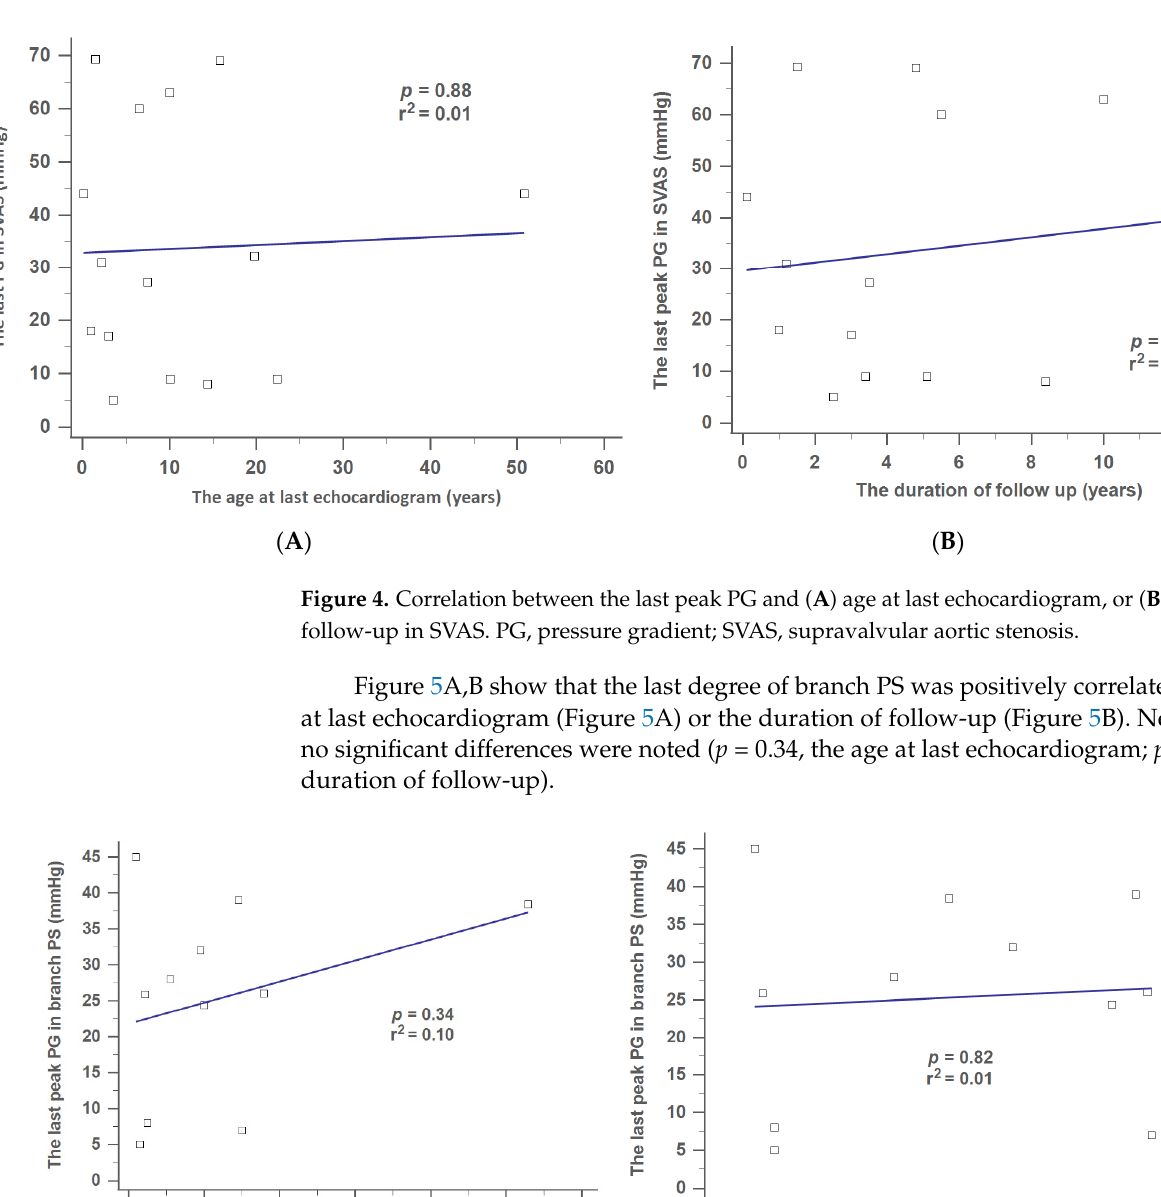
Figure 5. Correlation between the last peak PG and ( A ) age at last echocardiogram, or ( B ) duration of follow-up in branch PS. PG, pressure gradient; PS, pulmonary stenosis.